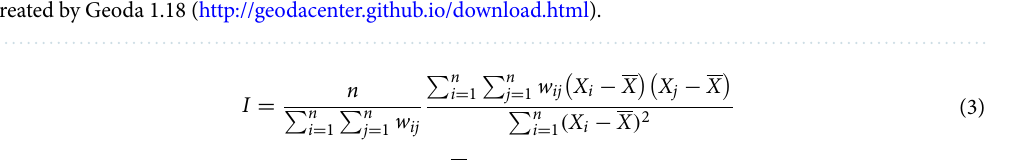
Figure 3. Hot and cold spots of Bitcoin mining activity with the corresponding significance map. ( a ) The hot spots (High-High clusters) and cold spots (Low-Low clusters) under the default setting of 999 permutations and a p-value ≤ 0.05 are marked in red and blue, respectively. ( b ) The corresponding significance map shows the clusters with the degree of significance reflected in increasingly darker shades of green, starting with 0.01 < p ≤ 0.05 (n = 215), then 0.001 < p ≤ 0.01 (n = 48) and p ≤ 0.001 (n = 5342). The ‘Not Significant’ category with p > 0.05 remains the same in Maps ( a ) and ( b ). Details of the statistics are supplied in “Methods” and